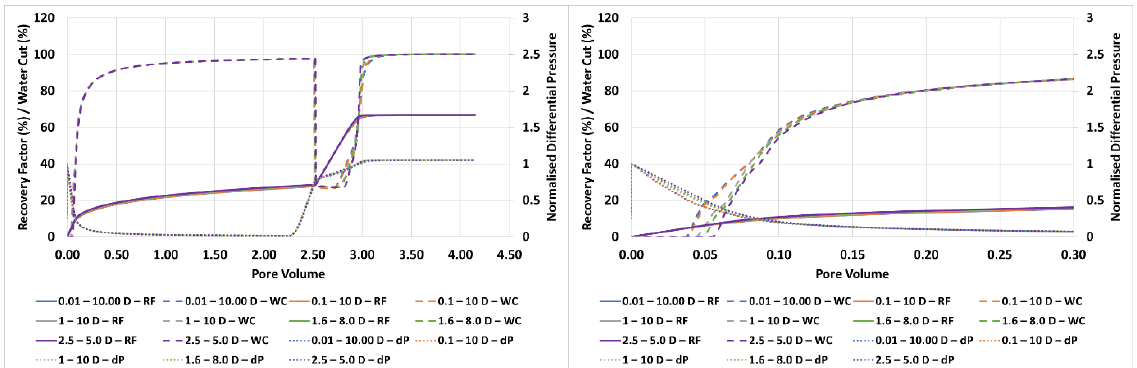
Figure 3. Oil recovery, water cut, and pressure drop during displacement of 2000 mPa.s oil at a range of permeability distributions. Full water and polymer flood ( left ) and early breakthrough ( right ).